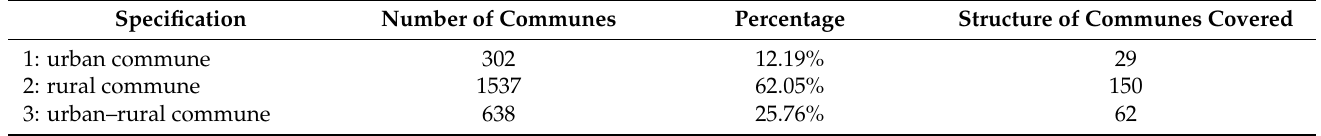
Table 2. Polish communes grouped by